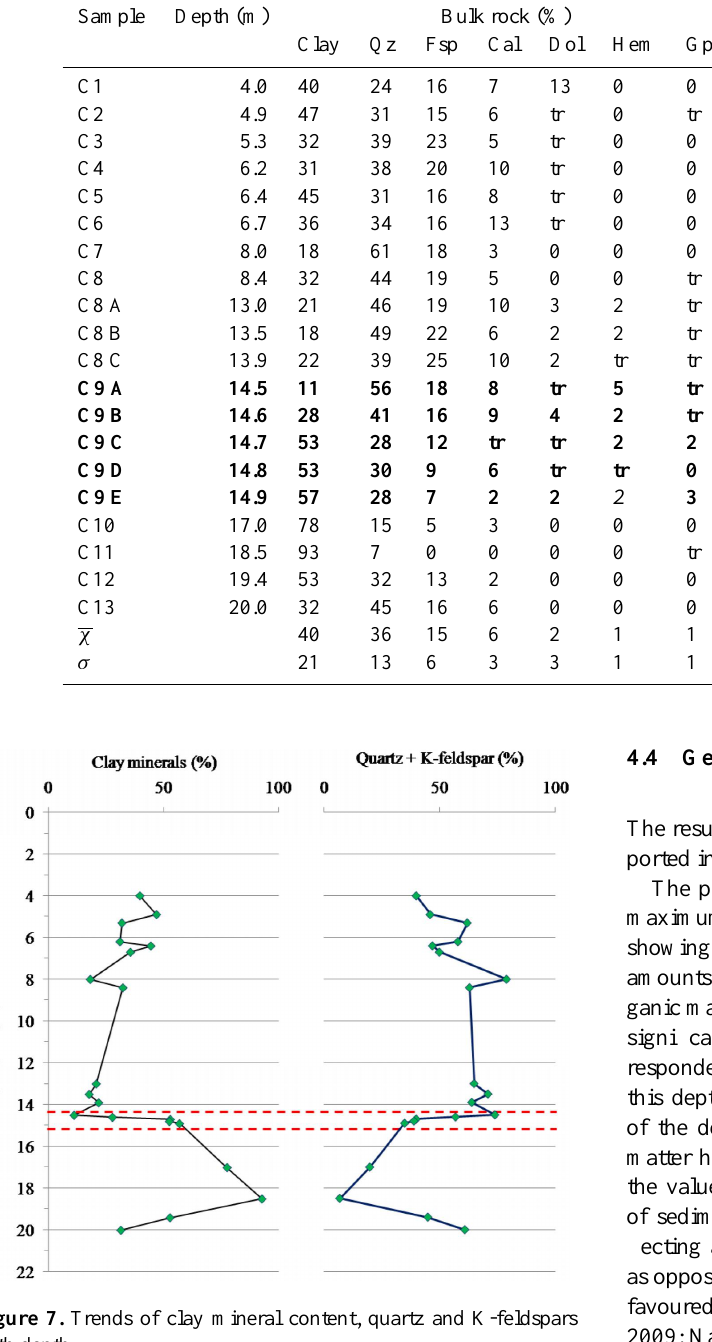
Figure 7. Trends of clay mineral content, quartz and K-feldspars with